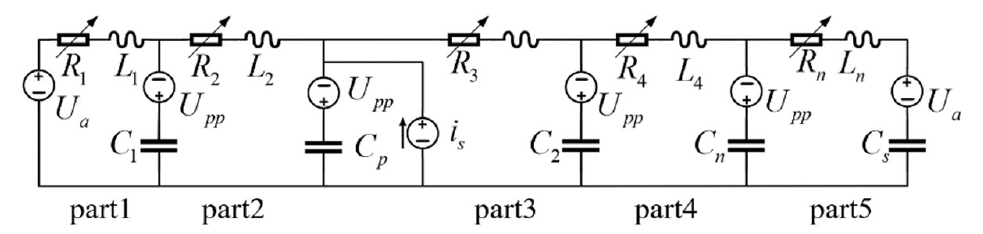
Figure 2. Circuit diagram of the modified model.